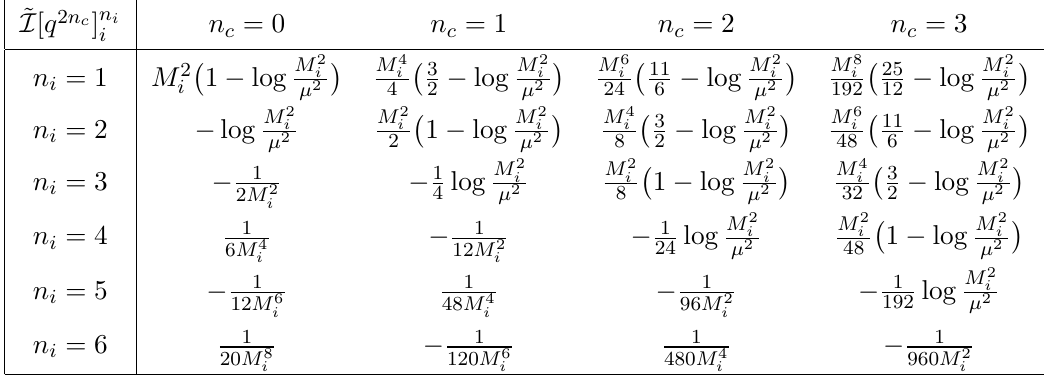
Table 7 . Commonly-used degenerate master integrals ~ I [ q 2 n c ] n i log 4 (cid:25) dropped. All nondegenerate (including mixed heavy-light) master integrals can be reduced to degenerate master integrals by eq.